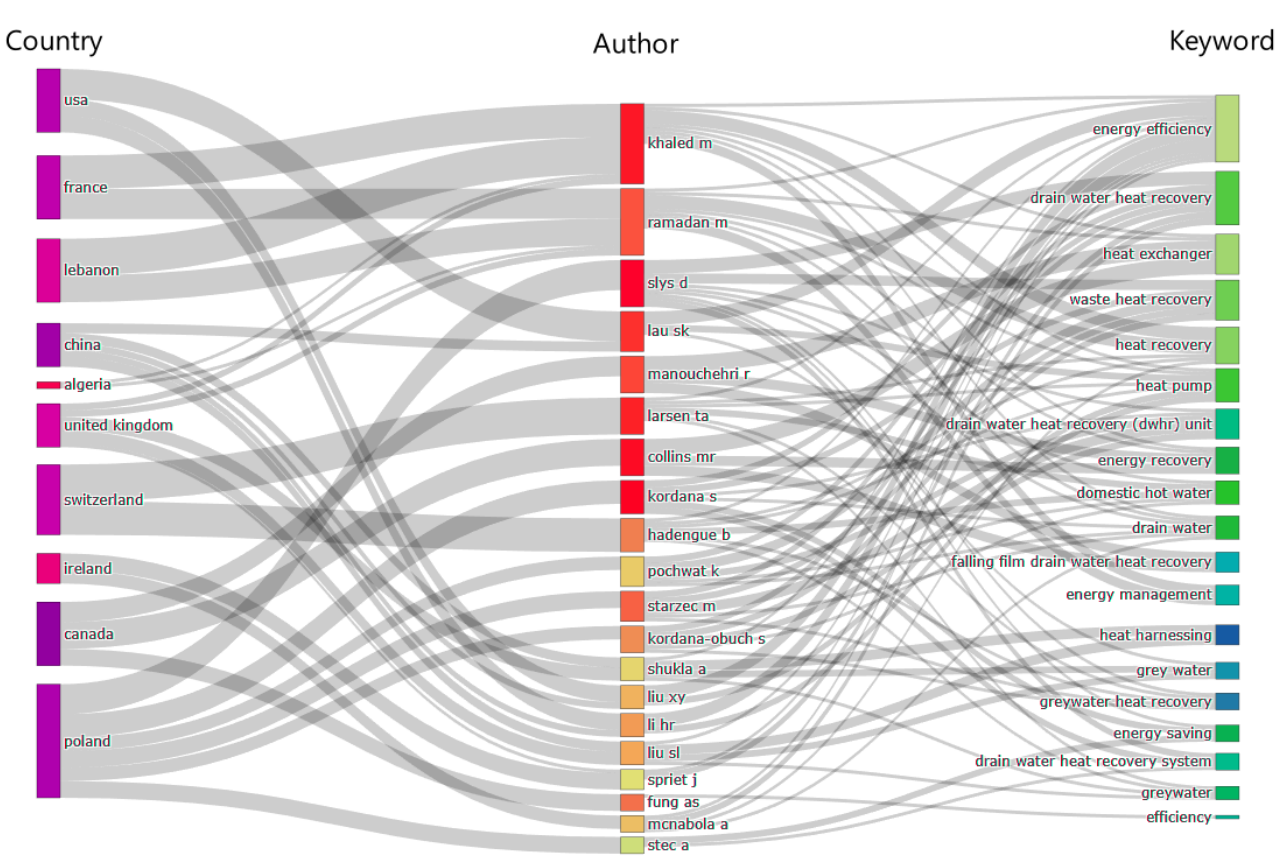
Figure 7. Sankey diagram for greywater energy recovery research.